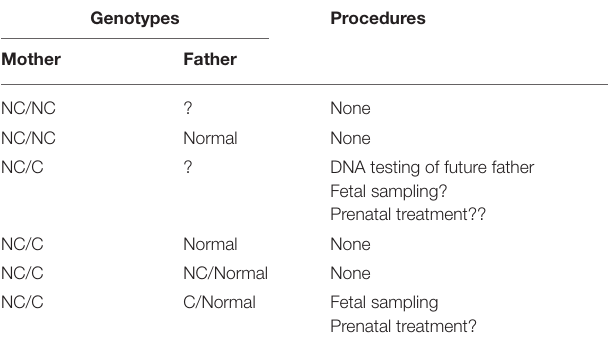
TABLE 2 | Planning of suggested procedures during pregnancy based on prospective parents genotype.